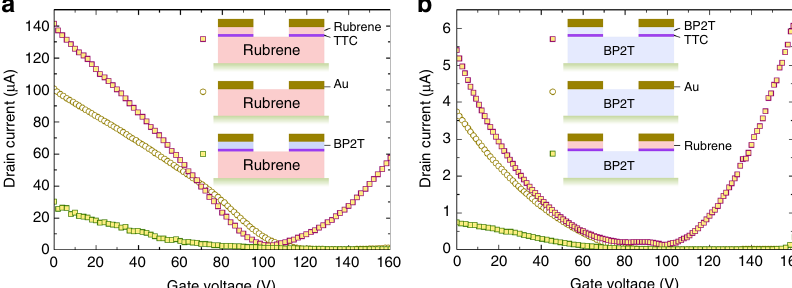
Fig. 4 Transfer characteristics of organic single-crystal fi eld-effect transistors with and without interlayer. a RU single crystal with Au electrodes (yellow circle), with Au/RU/TTC electrodes (magenta square), and Au/BP2T/TTC electrodes (green square). b BP2T single crystal with Au electrodes (yellow circle), with Au/BP2T/TTC electrodes (magenta square), and Au/RU/TTC electrodes (green